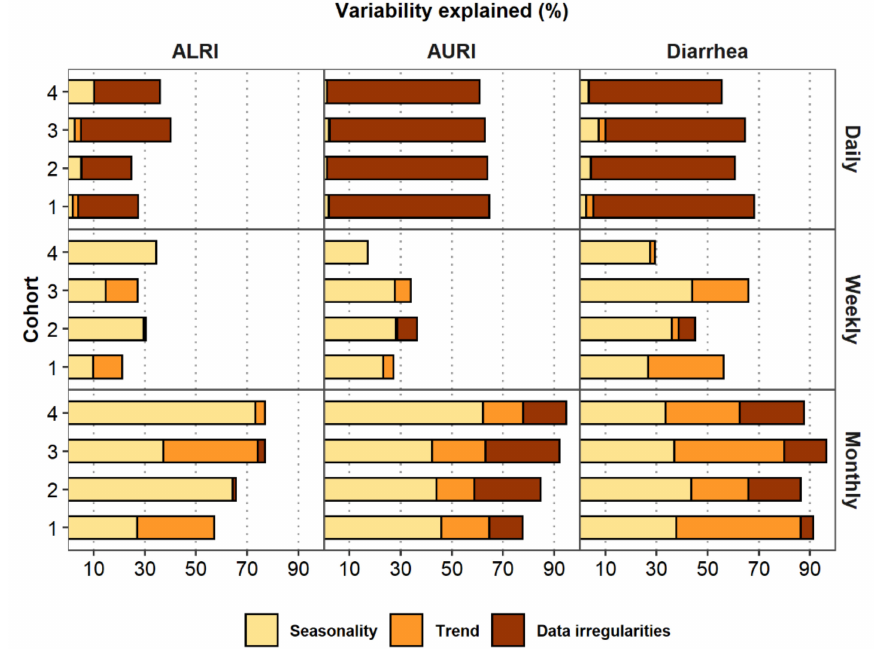
Figure 6. Model variability explained for daily, weekly, and monthly counts of AURI, ALRI, and diarrhea for each